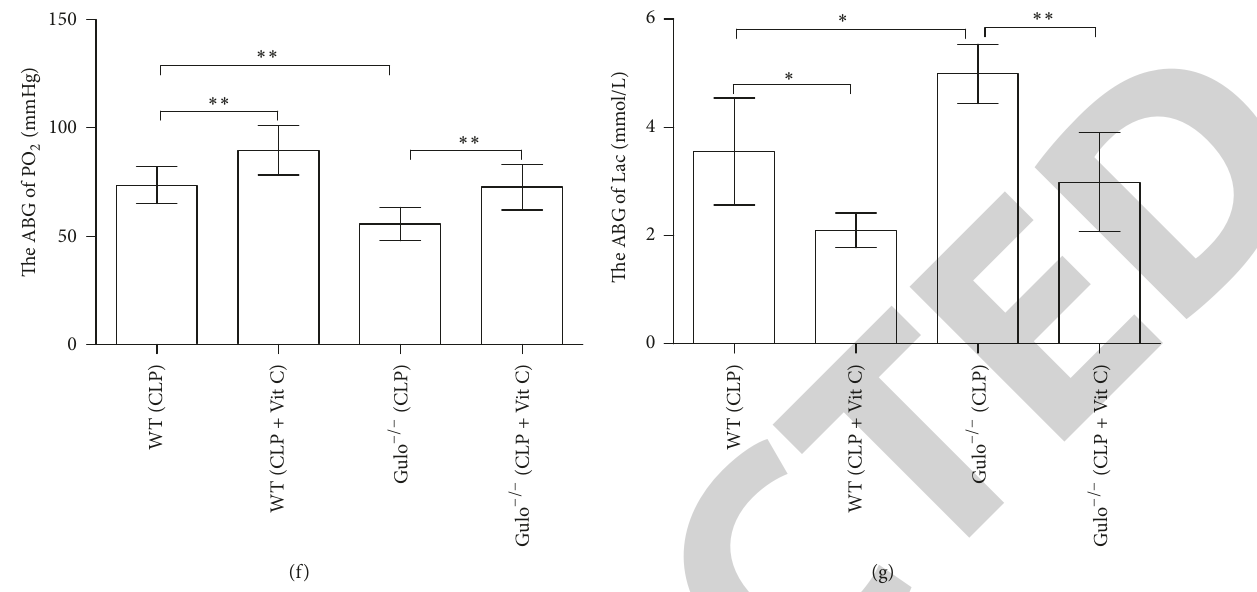
Figure 1: The impact of parenteral Vit C treatment on the 72-hour survival rate of septic mice and sepsis-induced MODS. The 72-hour survival rate of WT mice and Gulo −/− mice was improved on administration of 200 mg/Kg parenteral Vit C twice after CLP (a). Parenteral Vit C improved the biomarkers of liver (b and c), renal (d), respiratory (e and f), and circulatory (g) function in CLP-exposed WT mice and Vit C deficient Gulo −/− mice. The survival rate was analyzed by Kaplan-Meier via the log-rank test, 𝑛 = 50 per group. WT (CLP) versus WT (CLP + Vit C), 𝑝 < 0.01 . Gulo −/− (CLP) versus Gulo −/− (CLP + Vit C), 𝑝 < 0.01 . WT (CLP) versus Gulo −/− (CLP), 𝑝 < 0.05 . Data were represented as mean ± standard deviation (SD) and analyzed by software SPSS 17.0 with one-way ANOVA, 𝑛 = 4 per group, ∗ 𝑝 < 0.05 or ∗∗ 𝑝 < 0.01